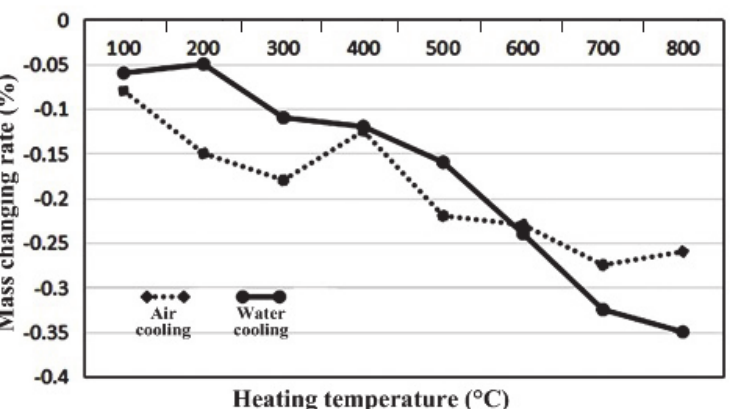
Figure 2: Mass changing rate after heating.